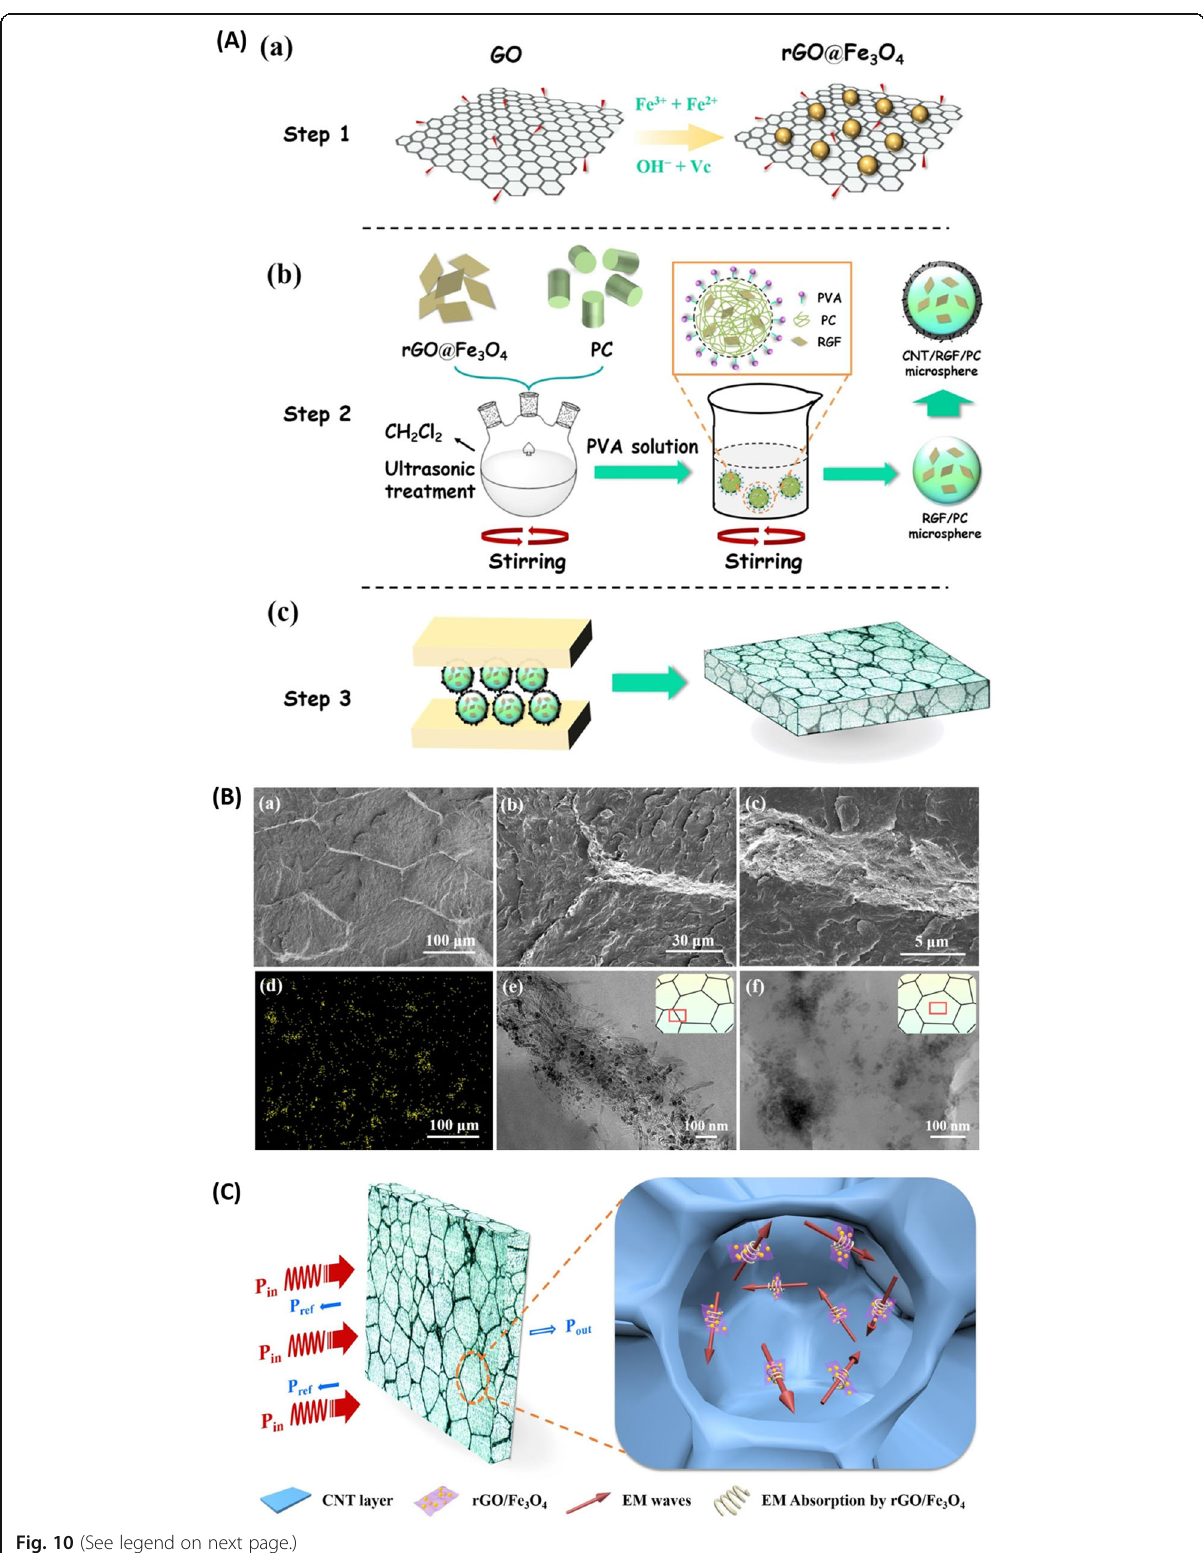
Fig. 10 (See legend on next